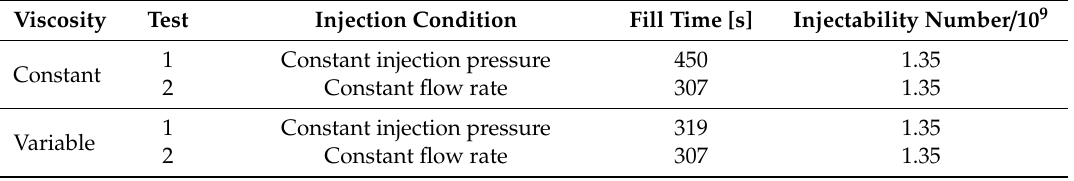
Figure 8. Viscosity curves for the filling simulations of the first hood geometry.